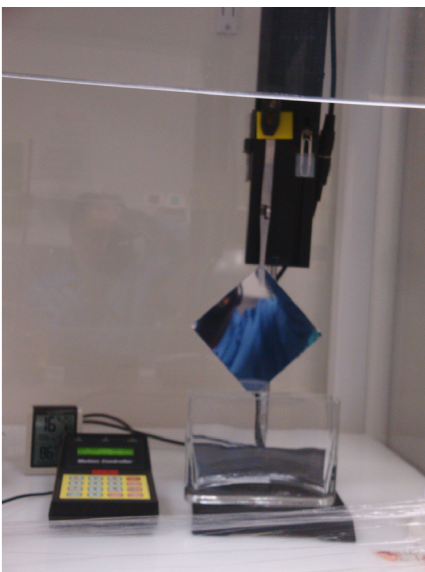
Figure 3: Custom dip coater. It consists of a ring stand, ring stand clip for the samples, a CNC motor Sherline Direct 6559 machine1- axis slide, 13 ″ table, stepper motor and mount, CNC linear con- troller held by the ring stand and in a vertical position, and a glass container for the